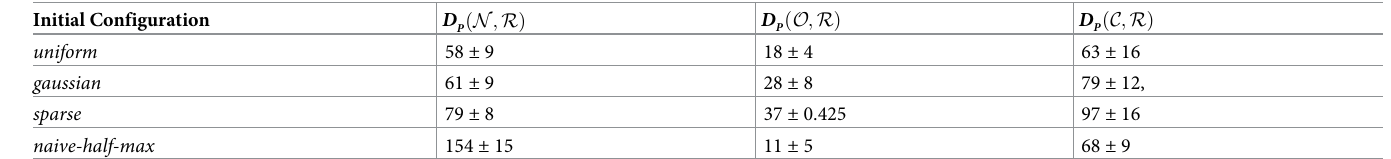
Table 3. Pairwise distance measures for each of the 4 initial network configurations. Mean and standard deviation reported for 30 trials. Initial Configuration